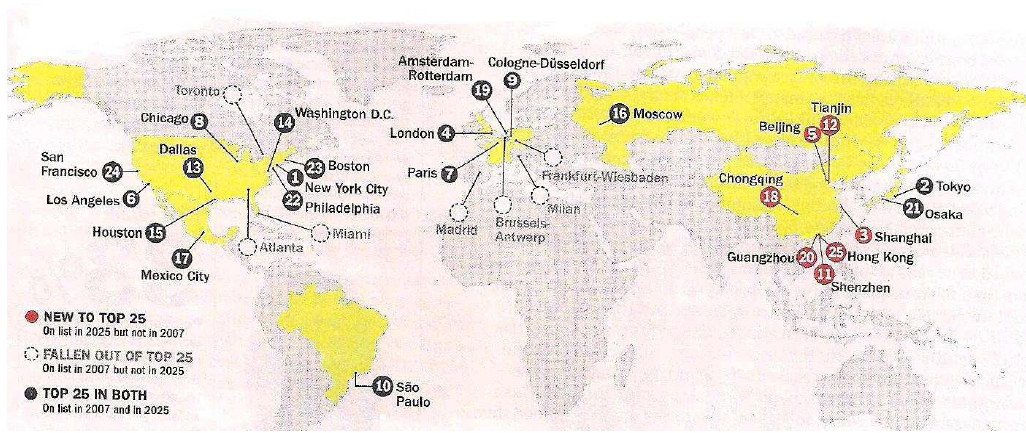
Source: McKinsey Global Institute, March